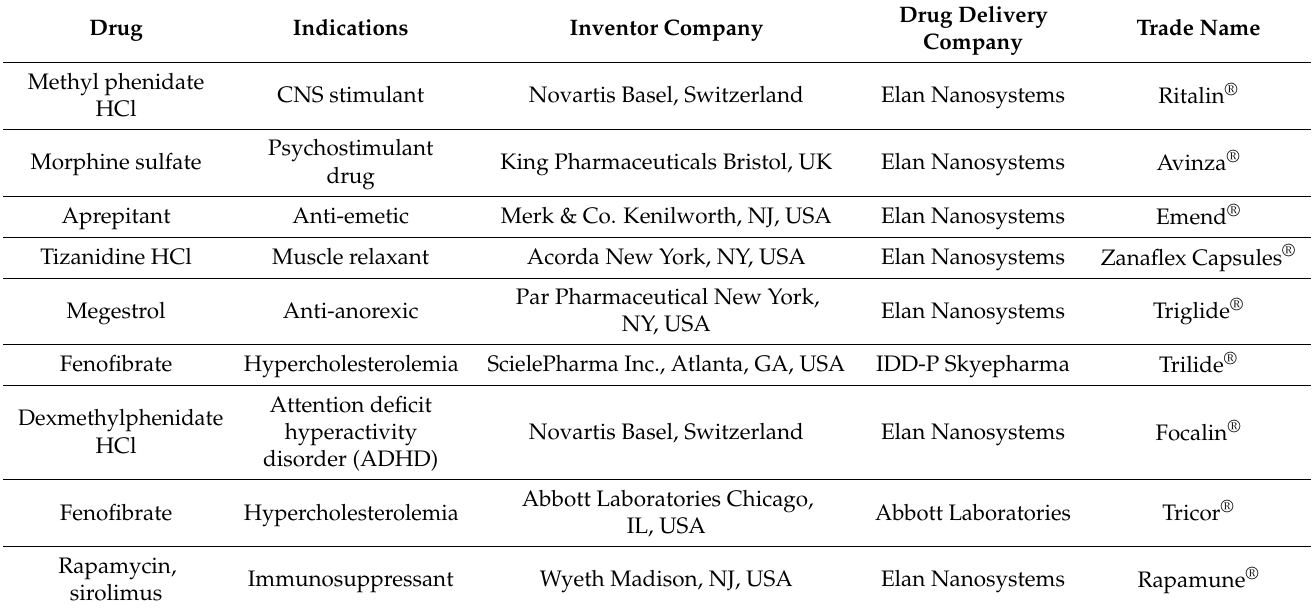
Table 4. Marketed products based on nanoparticle techniques [69].